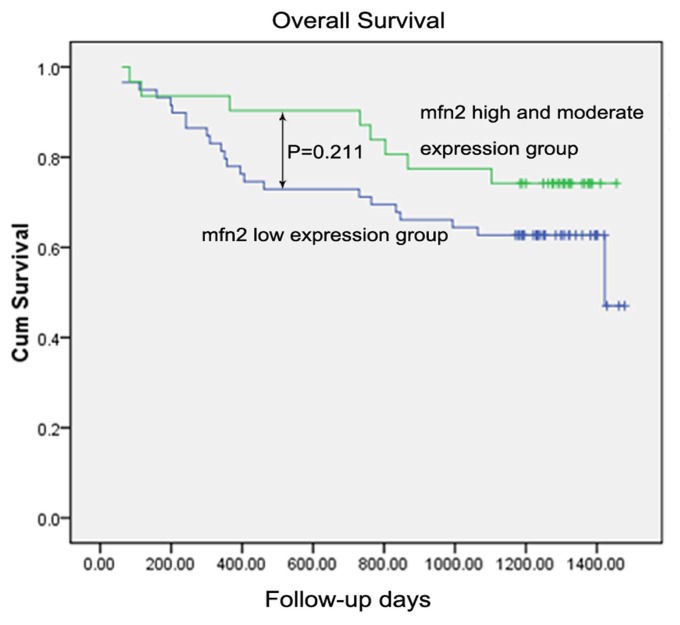
Kaplan-Meier survival curves according to the expression level of Mfn2 in 90 gastric cancer patients. The p-value between two groups was 0.211.